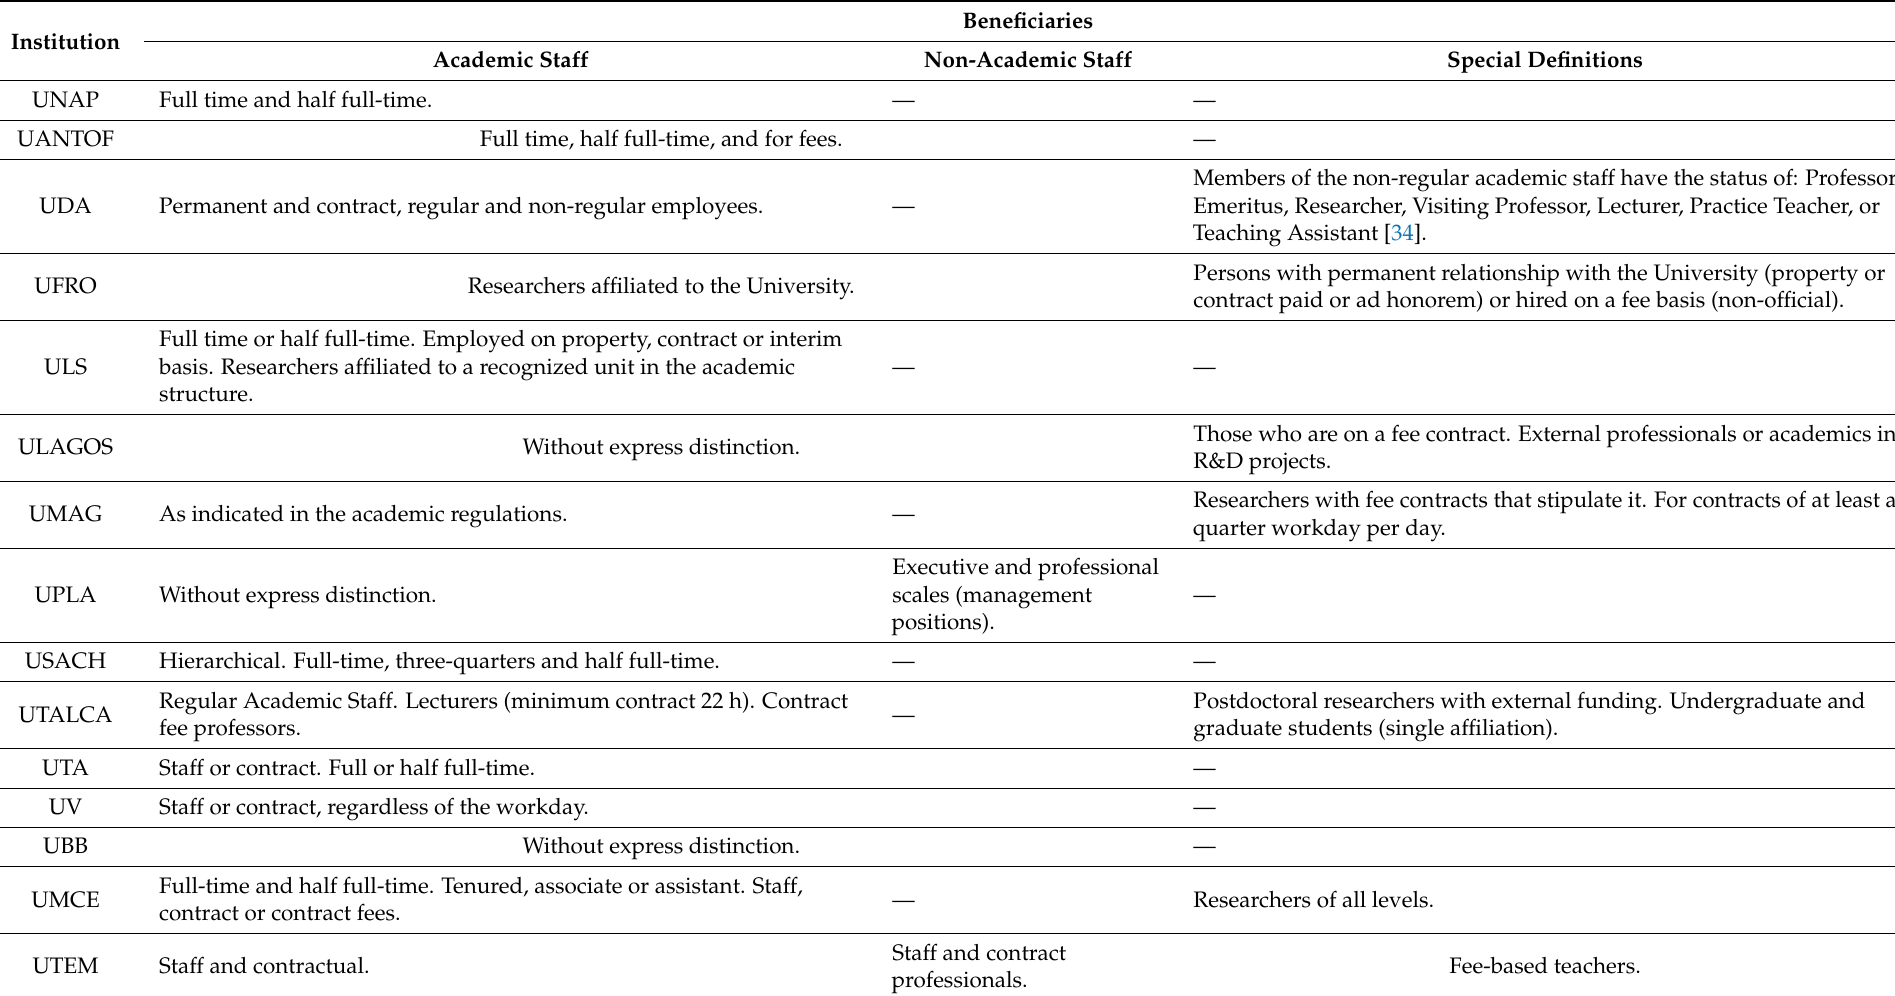
Table 3. Beneficiaries with access to the incentive